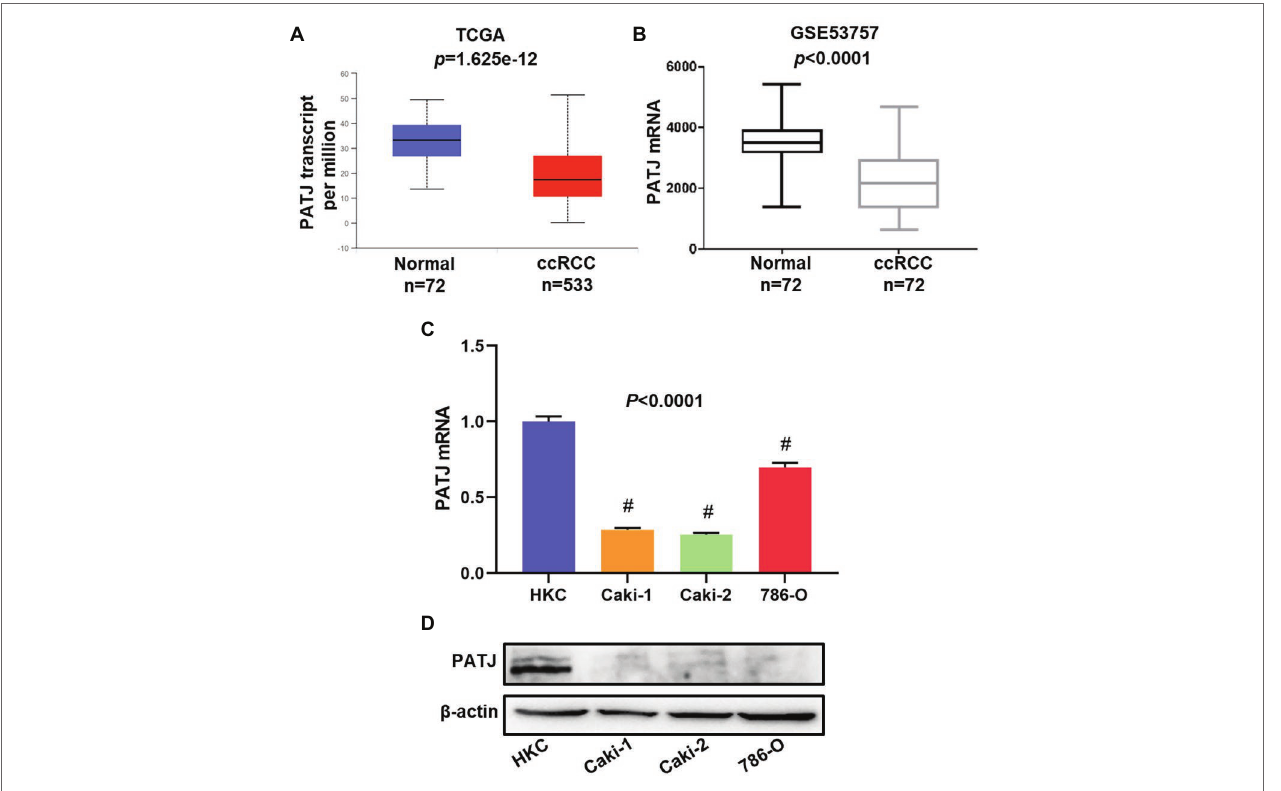
FIGURE 1 | Downregulation of PATJ mRNA in clear cell renal cell carcinoma (ccRCC) tissues and cell lines. (A) The Cancer Genome Atlas (TCGA) database data. The box plots and p were generated using The UALCAN (http://ualcan.path.uab.edu/index.html). (B) GSE53757 data on PATJ mRNA in 72 ccRCC patients. (C) Expression analysis of PATJ mRNA in a human renal tubular epithelial cell HKC line and three ccRCC cell lines detected by using quantitative reverse transcriptase-polymerase chain reaction (qRT-PCR). # p < 0.01 and compare to (HKC) cell. (D) Western blot. A HKC cell line and three ccRCC cell lines were grown and subjected to Western blot analysis of PATJ protein.